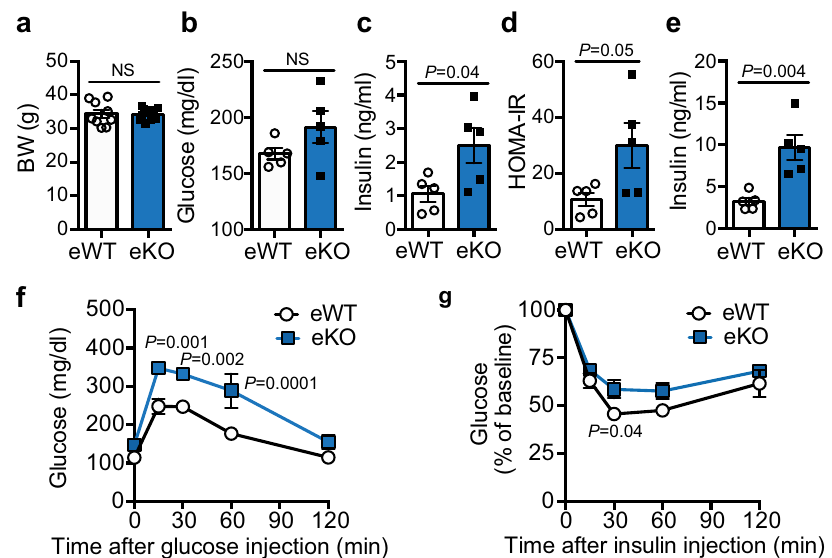
Fig. 2 BMPER depletion in ECs leads to glucose dysregulation. Metabolic studies were performed with BMPER eKO and eWT mice at 4 months after tamoxifen injection. a Body weight (BW). b – d Fasted glucose and insulin, HOMA-IR. e Fed insulin. f , g Glucose and insulin tolerance tests. eWT, BMPER fl ox/ fl ox ; Cdh5-CreER – / – . eKO, BMPER fl ox/ fl ox ; Cdh5-Cre ER + / – . n = 9 mice ( a eWT), 10 mice ( a eKO), 5 mice ( b – g ). Data are presented as mean values ± SEM. NS not signi fi cant. Analysis was unpaired two-tailed Student ’ s t test (for a – e ) or two-way ANOVA followed by Fisher ’ s LSD multiple comparison test (for f , g ).